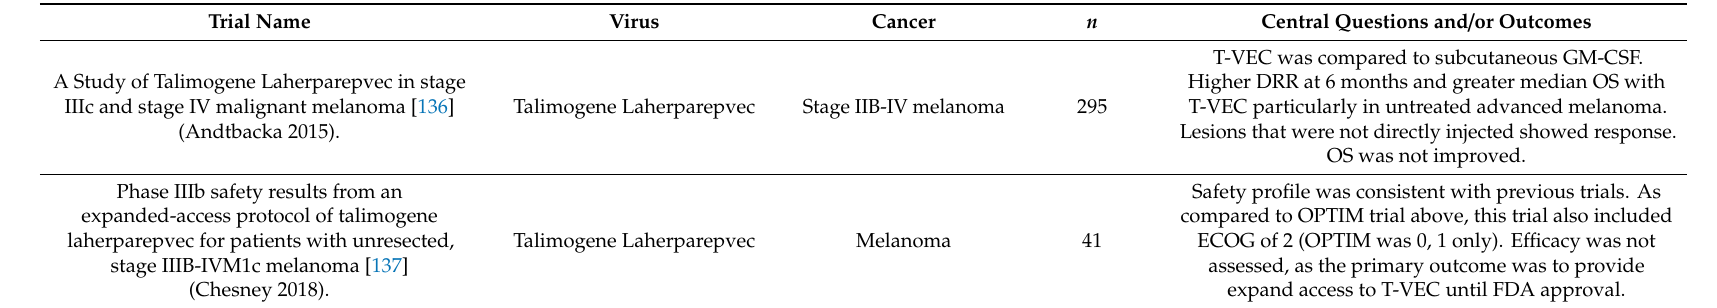
Table 5. Summary of oncolytic virus use in Phase III clinical